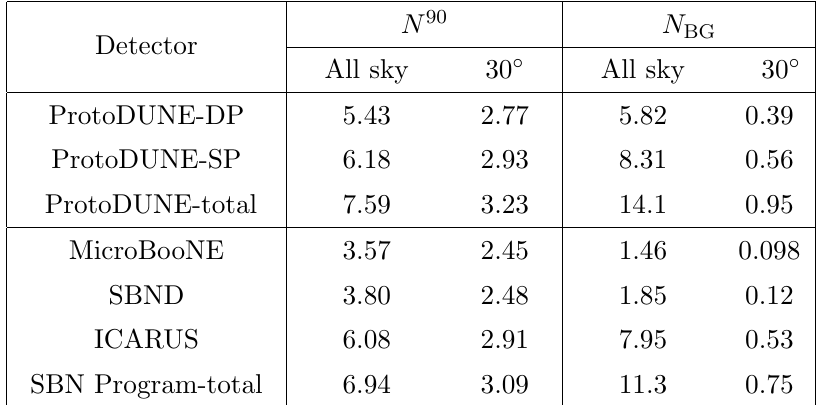
Table 2 . N 90 values for all sky (second column) and 30 (cid:14) (third column) at various surface detectors. The numbers are computed with respect to the expected number of (atmospheric neutrino-induced) background events ( N BG ) during one-year operation re(cid:13)ecting the corresponding D f .